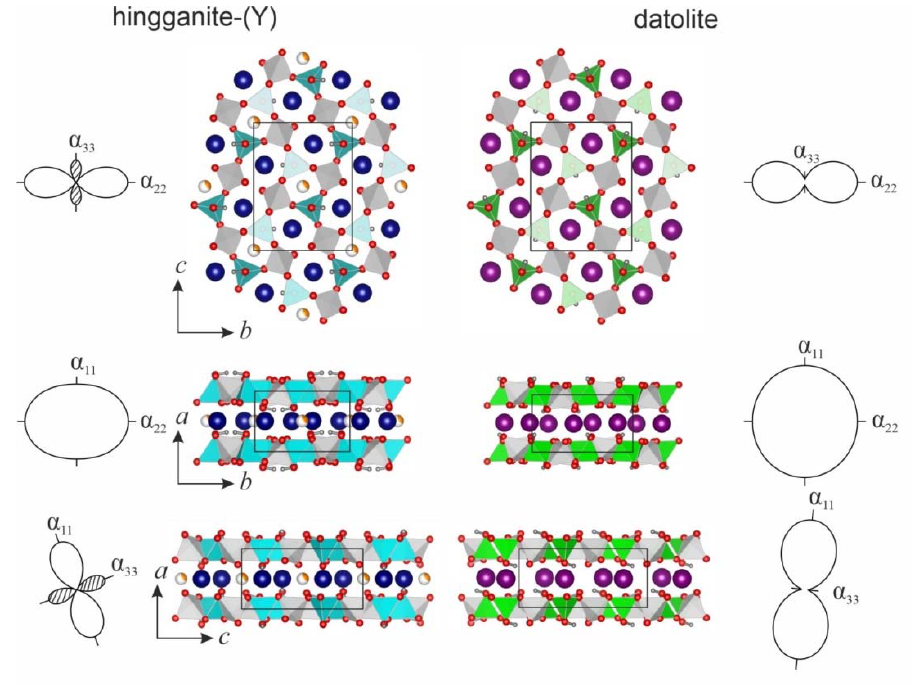
Figure 8. Crystal structures of hingganite-(Y) and datolite at − 173 ◦ C with the section of the averaged thermal expansion. The sections of thermal expansion for datolite were calculated using the data of Rinaldi et al. [20]. SiO 4 tetrahedra are given in grey; O atoms are shown as red spheres, H atoms as grey spheres, Y as dark blue sphere, and Ca as violet spheres. Q O 4 tetrahedra are shown in light blue ( Q = Be for hingganite-(Y)) and green ( Q = B for datolite). Vacancy and Fe 2 + in the M site are shown as a percentage by white and orange, respectively.